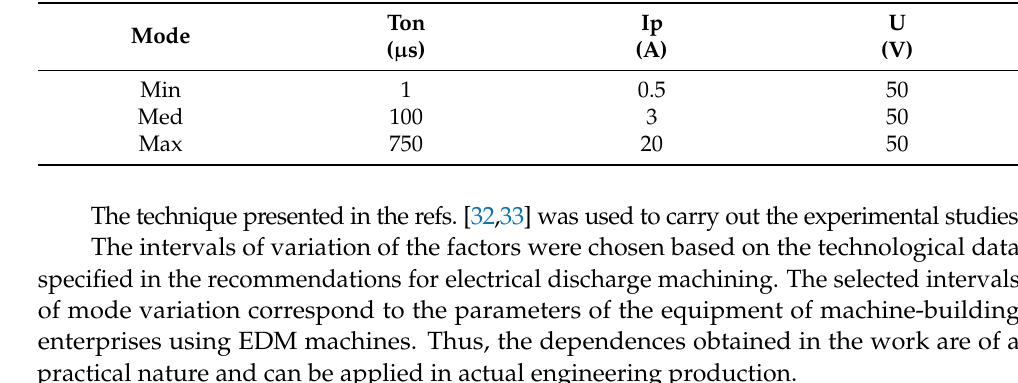
Table 1. Processing modes for bimetallic material